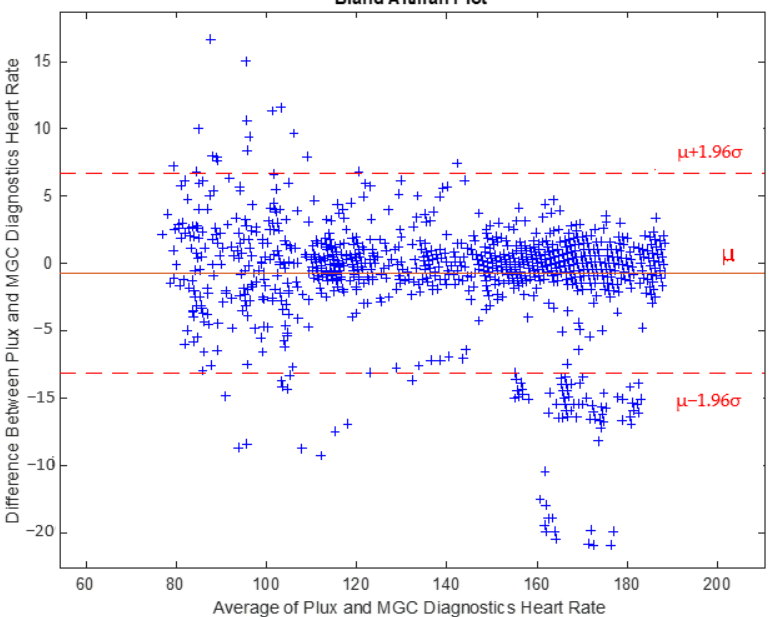
Figure 1. Bland Altman Bland–Altman Plot indicating mean difference in HR detection between the PluxECG and the lab-based 12-lead ECG system measurement. Mean bias and Limits of Agreement (LOA) (95% LoA) are shown.